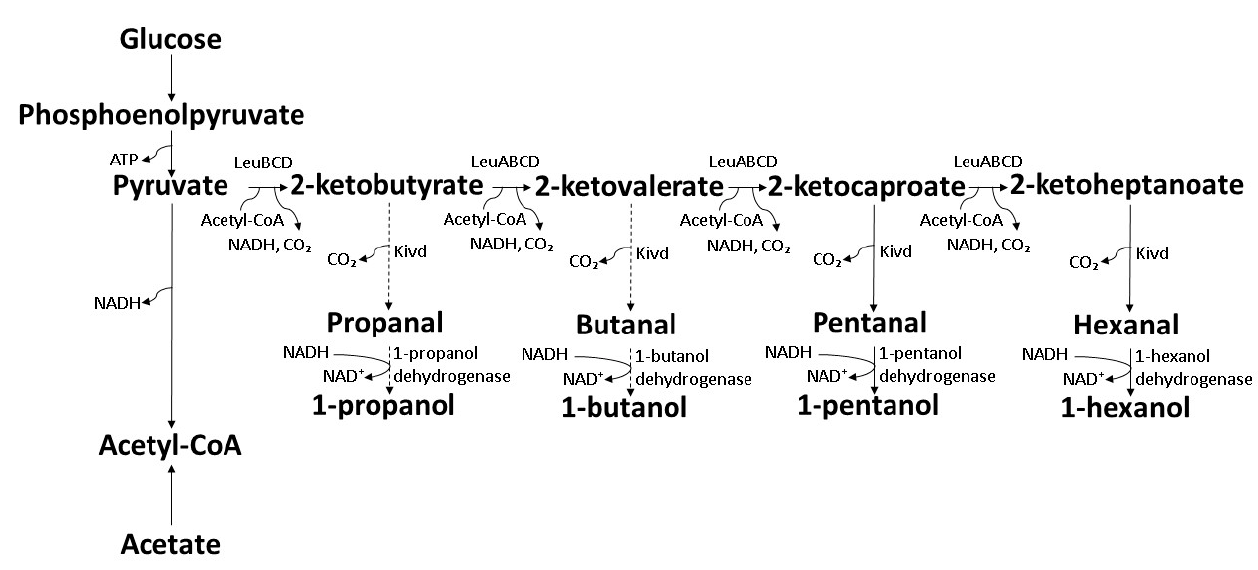
Figure 9. Biosynthesis of 1-pentanol by genetically engineered E. coli BW25113 through interactive elongation cycles of 2-letoacids [116]. Dash arrow indicates lower selectivity toward the reaction.